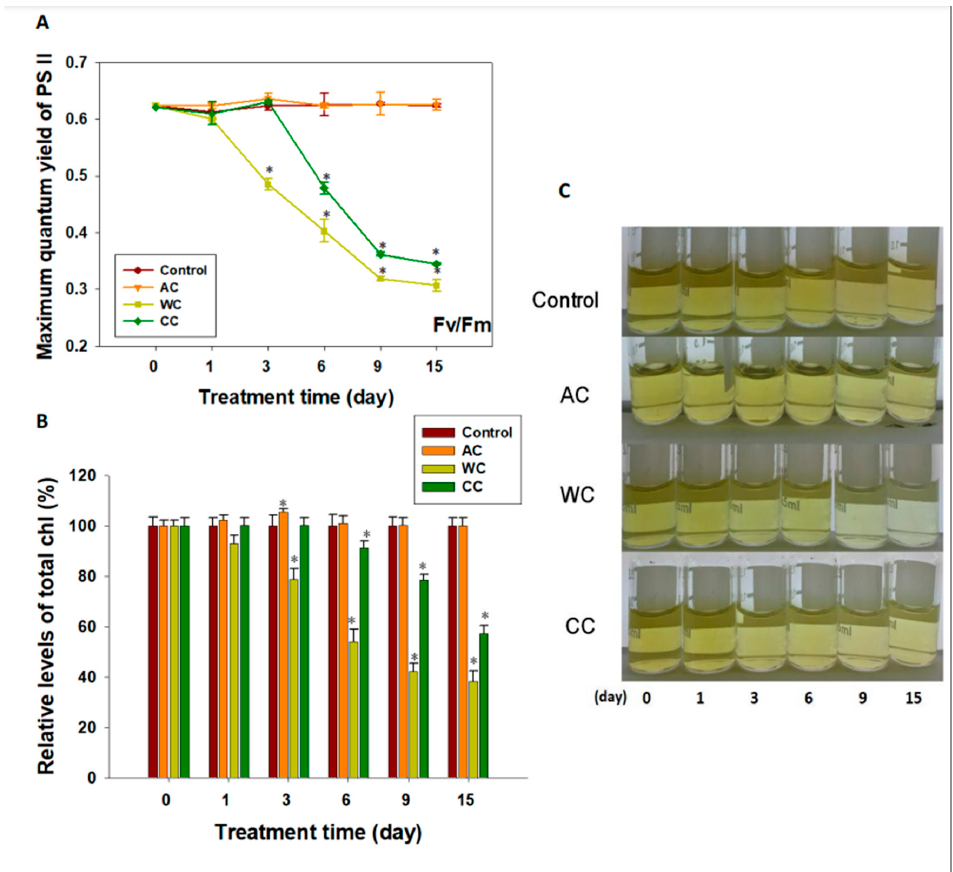
Figure 1. Consequences of different stresses on the photosynthetic activity and apparatus of the symbionts in H. crispa . ( A ) Maximum quantum yield of photosystem II (PSII) ( n = 3); ( B ) Total chlorophyll content ( n = 3); ( C ) Crude chlorophyll extract. AC, acidification conditions; WC, warming conditions; CC, combined conditions. Asterisks (*) indicate p -values < 0.05.